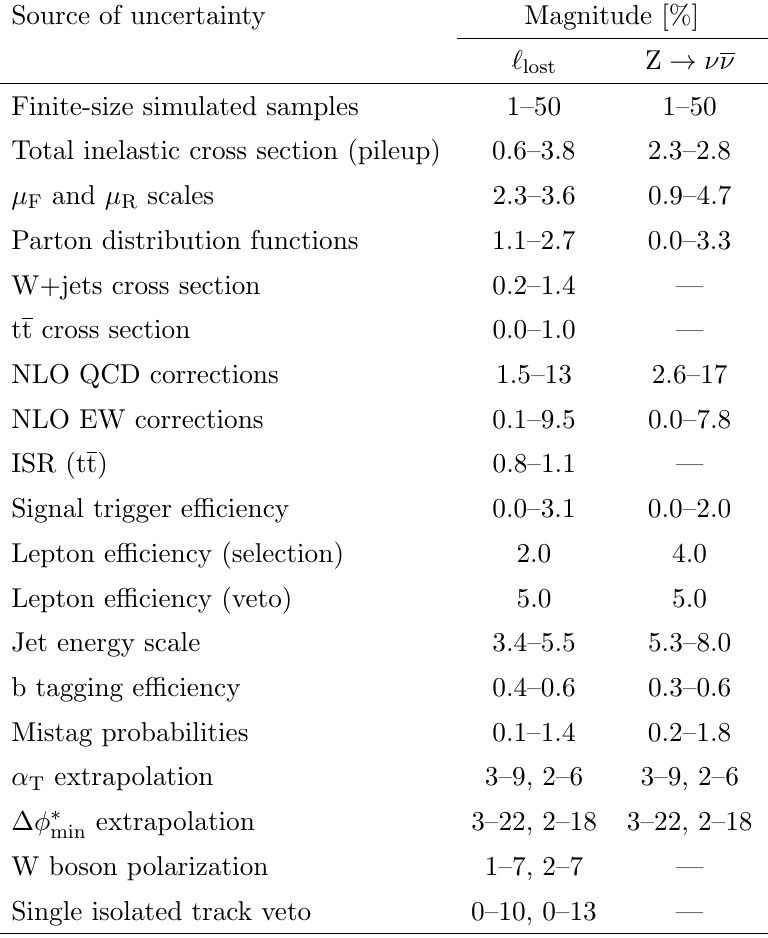
Table 2 . Systematic uncertainties in the ‘ lost and Z ! (cid:23)(cid:23) background evaluation. The quoted ranges are representative of the minimum and maximum variations observed across all bins of the signal region. Pairs of ranges are quoted for uncertainties determined from closure tests in data, which correspond to variations as a function of n jet and H T ,